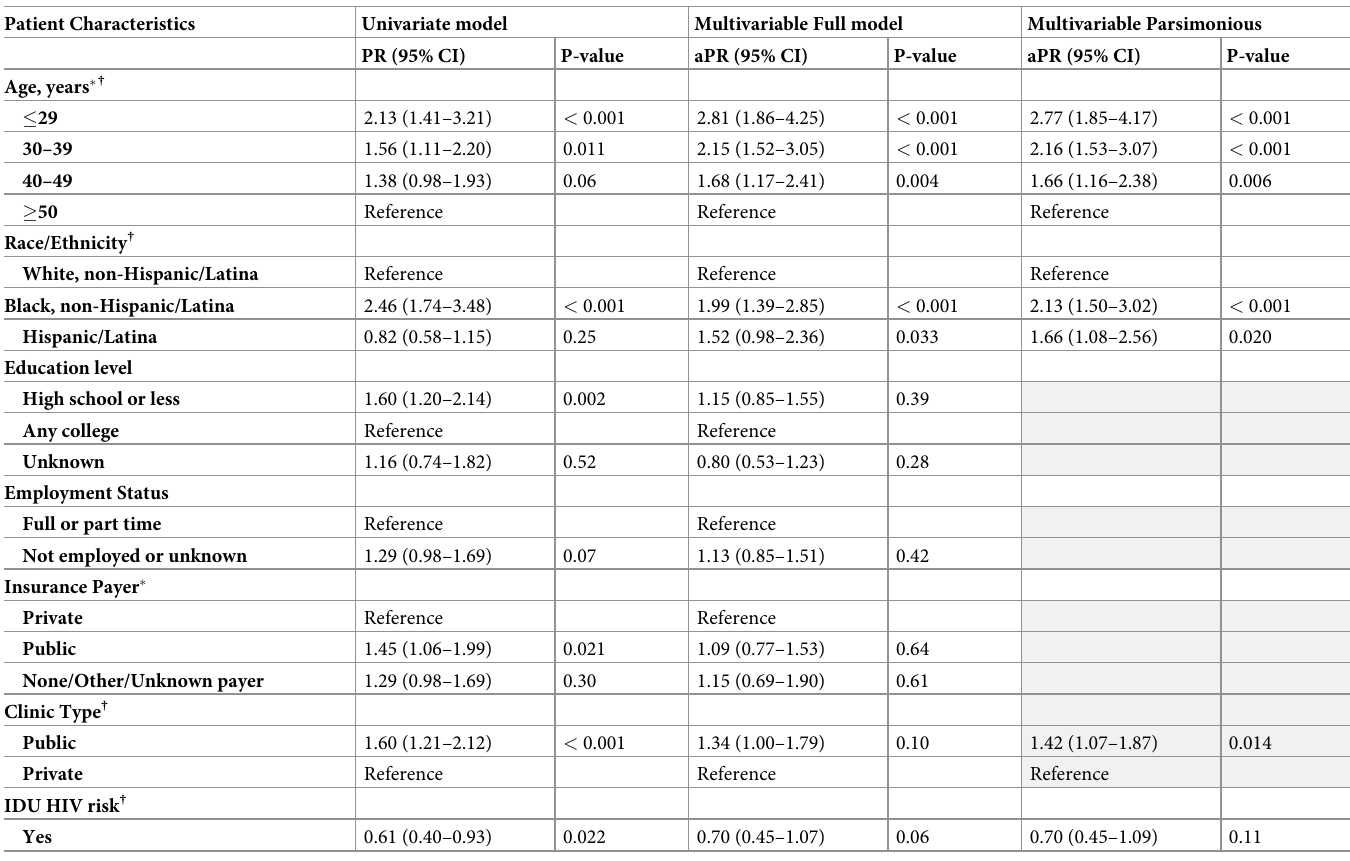
There are errors in Table 3. Please view the correct Table 3 here. Table 3. Generalized Estimating Equation Analyses of Factors Associated With Not Having Viral Suppression When Prescribed ART, The HIV Outpatient Study, 2010–2015 (N = 795). Patient